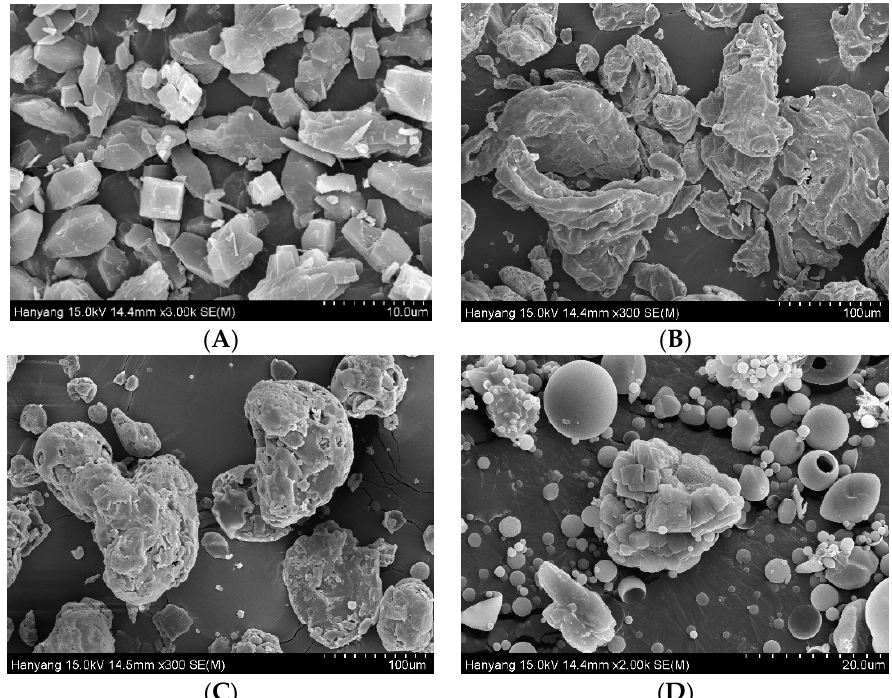
Figure 3. SEM images of ( A ) MTX powder ( × 3000), ( B ) Na-CMC ( × 300), ( C ) SLS ( × 300), and ( D ) the F6 formulation ( × 2000).